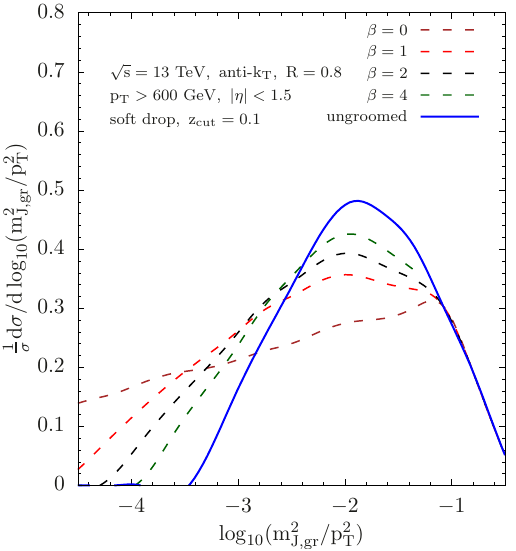
Figure 8 . The ungroomed (solid blue) and groomed (dashed lines) jet mass distributions for di(cid:11)erent values of the angular exponent (cid:12) . The same kinematical setup is used as in (cid:12)gure 6. We only show the purely perturbative results plotted as a function of log (cid:12) , the ungroomed distribution is recovered from the groomed ! 1